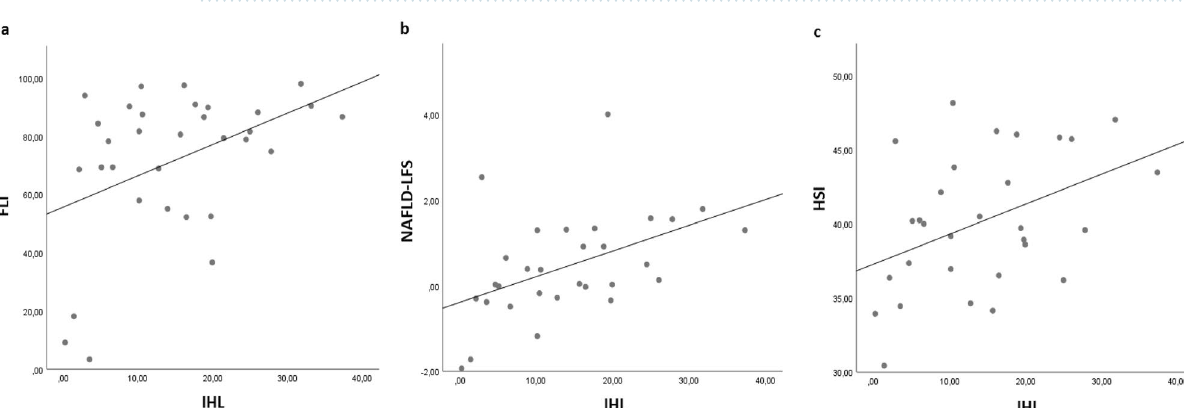
Figure 1. AUROC representation of NAFLD prediction by FLI ( a ), NAFLD-LFS ( b ) and HSI ( c ); the analyses show AUROC values of 0.731 (FLI), 0.752 (NAFLD-LFS) and 0.770 (HSI).